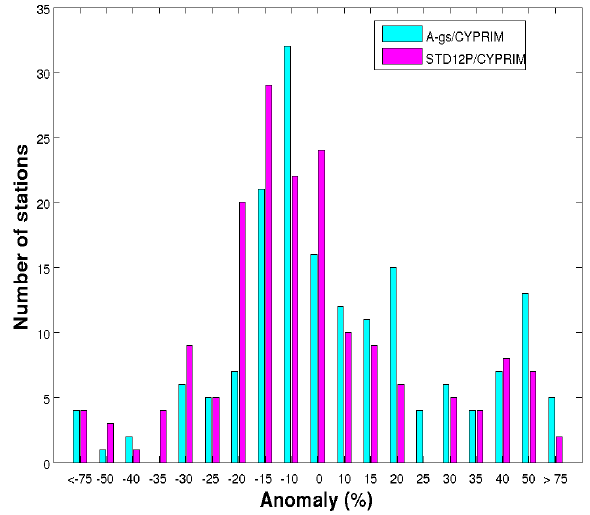
Figure 5: Histogram of the number of stations in each class of anomaly of discharge for 2 Fig. 5. Histogram of the number of stations in each class of anomaly ISBA-A-gs and ISBA-Standard with the CYPRIM climate forcing when compared to 3 of discharge for ISBA-A-gs and ISBA-Standard with the CYPRIM observations. Data are for the annual mean. 4 climate forcing when compared to observations. Data are for the annual mean.